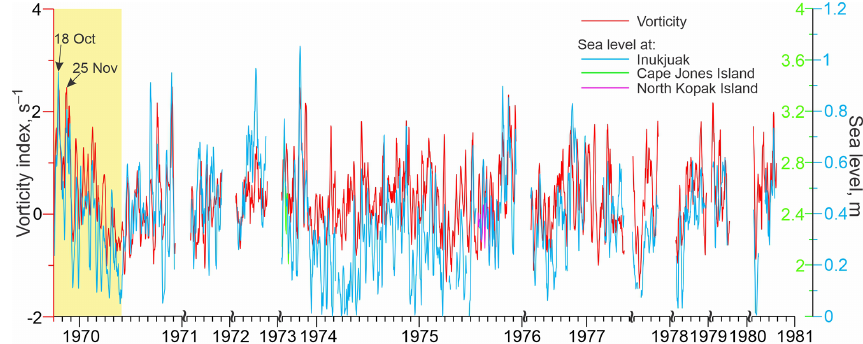
Figure 9. Time series of 7d running mean for daily atmospheric vorticity index (red,s − 1 ) over Hudson Bay and daily mean sea level (m) measured at the tide gauge in Inukjuak (blue), Cape Jones Island (green), and North Kopak Island (purple). Yellow shading highlights October–May 1969–70. Black arrows indicate two cyclonic storms in 18 October and 25 November 1969 with atmospheric forcing shown in Fig. 7a and b, respectively. Right vertical axis shows sea-level scale for Inukjuak (blue), Cape Jones Island, and North Kopak Island (green).